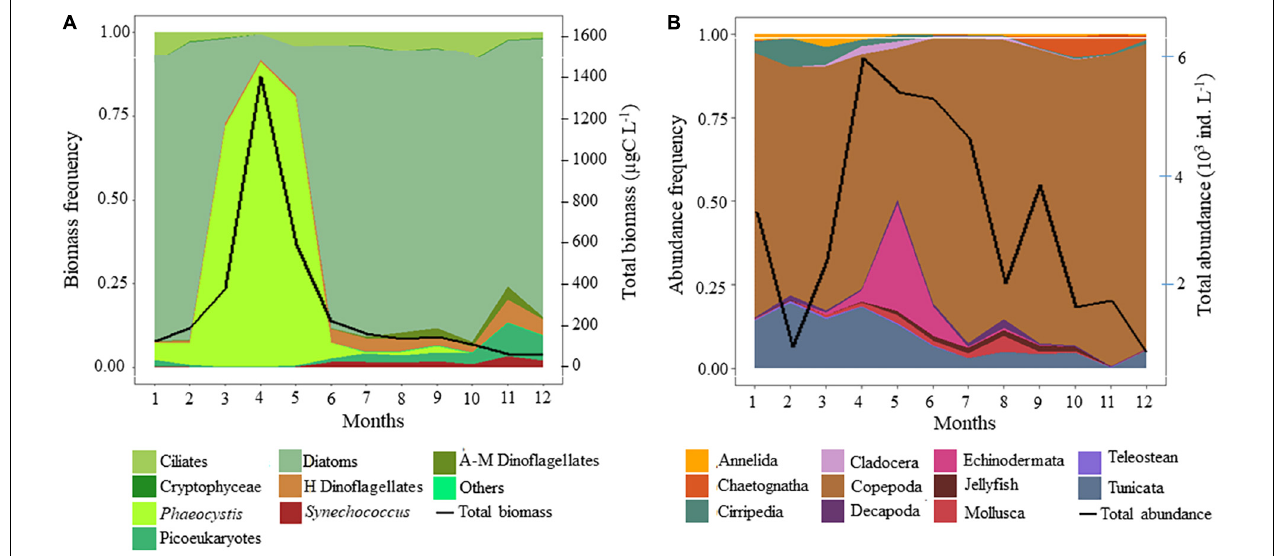
FIGURE 2 | Seasonal variations in panel (A) phytoplankton composition (carbon biomass frequency) and total phytoplankton biomass (black line, µ gC L − 1 ), and (B) zooplankton composition (abundance frequency) and total zooplankton abundance (black line,10 3 ind. L − 1 ). A-M, Auto- Mixotrophic; H, Heterotrophic. Teleostean included fish larvae and eggs. Jellyfish included Cnidaria and